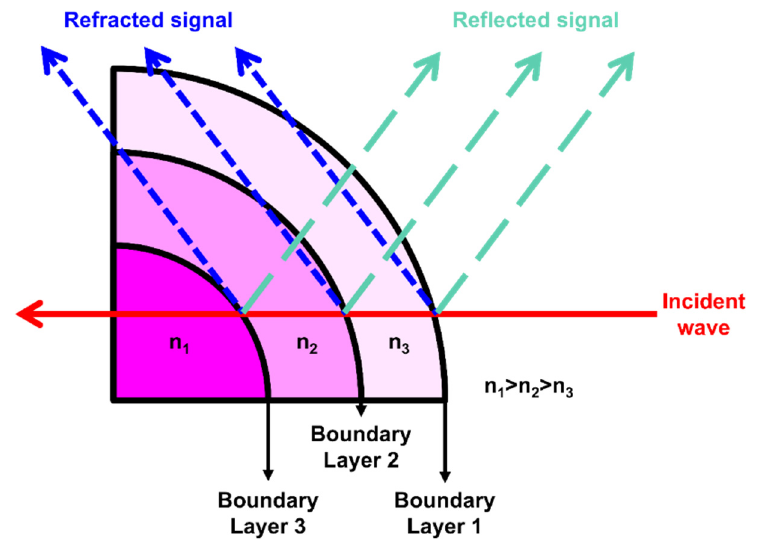
Figure 8. A schematic of boundary layers formation according to plasma distribution; electromagnetic wave incident on the plasma (Incident wave), Electromagnetic waves reflected and refracted at the boundary layer (Refracted signal, Reflected signal), plasma distribution (n 1 , n 2 , n 3 ).